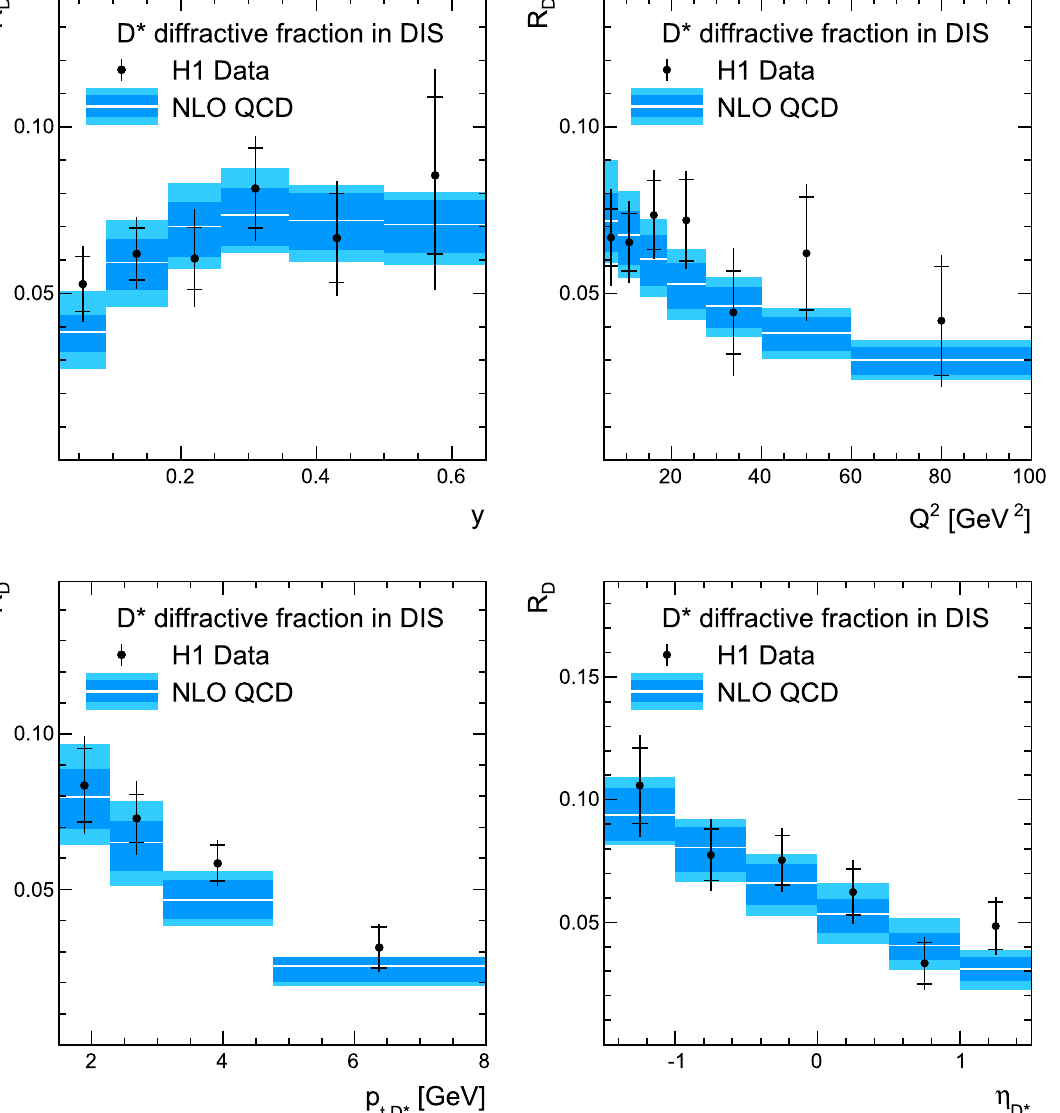
Fig. 7 Thediffractivefraction, R D ,measuredasaratioofbinaveraged diffractivetonon-diffractive D ∗ productionsingledifferentialcrosssec- tions in deep inelastic scattering as a function of y , Q 2 , p t , D ∗ and η D ∗ . The data ratios are represented with dots , where the inner error bars indicate statistical uncertainties and the outer error bars represent the statistical and systematic uncertainties added in quadrature. The central